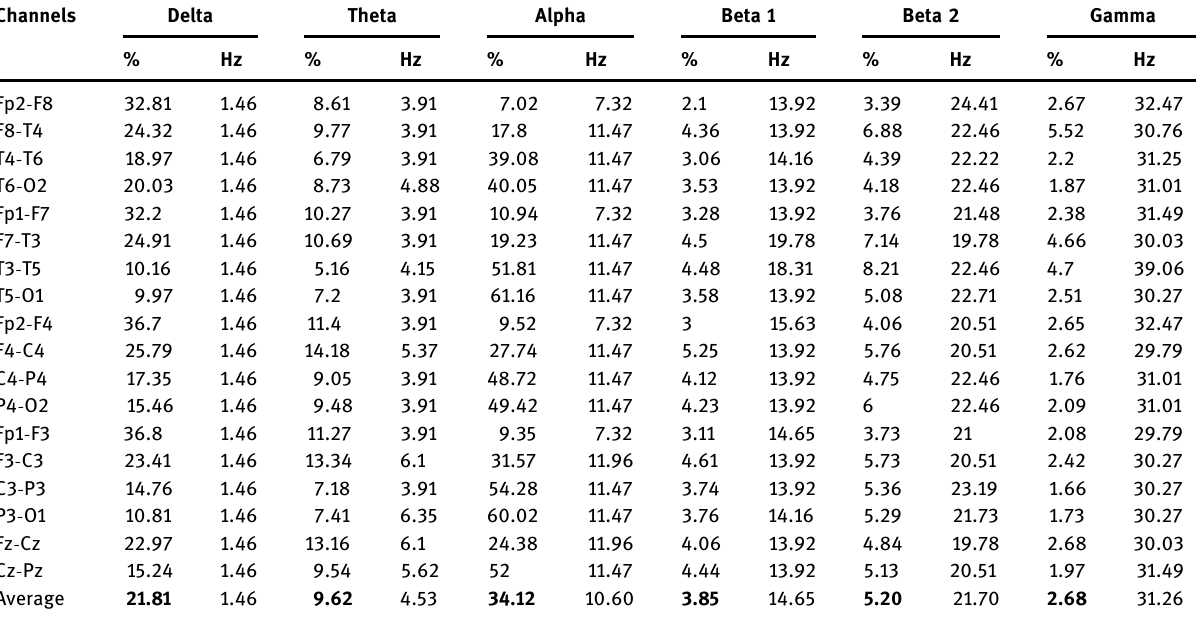
Table 2: Pre ( after 1 h ) : Amplitude of each channel of subject